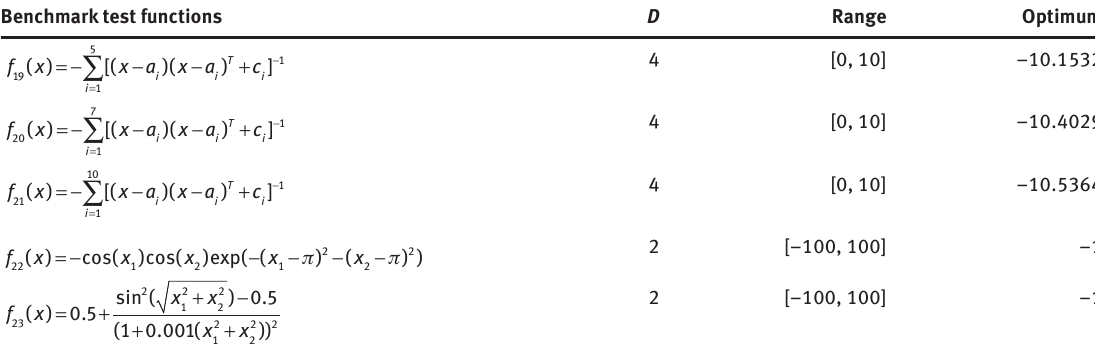
Table 2: Simulation Results for Test Functions f Benchmark functions